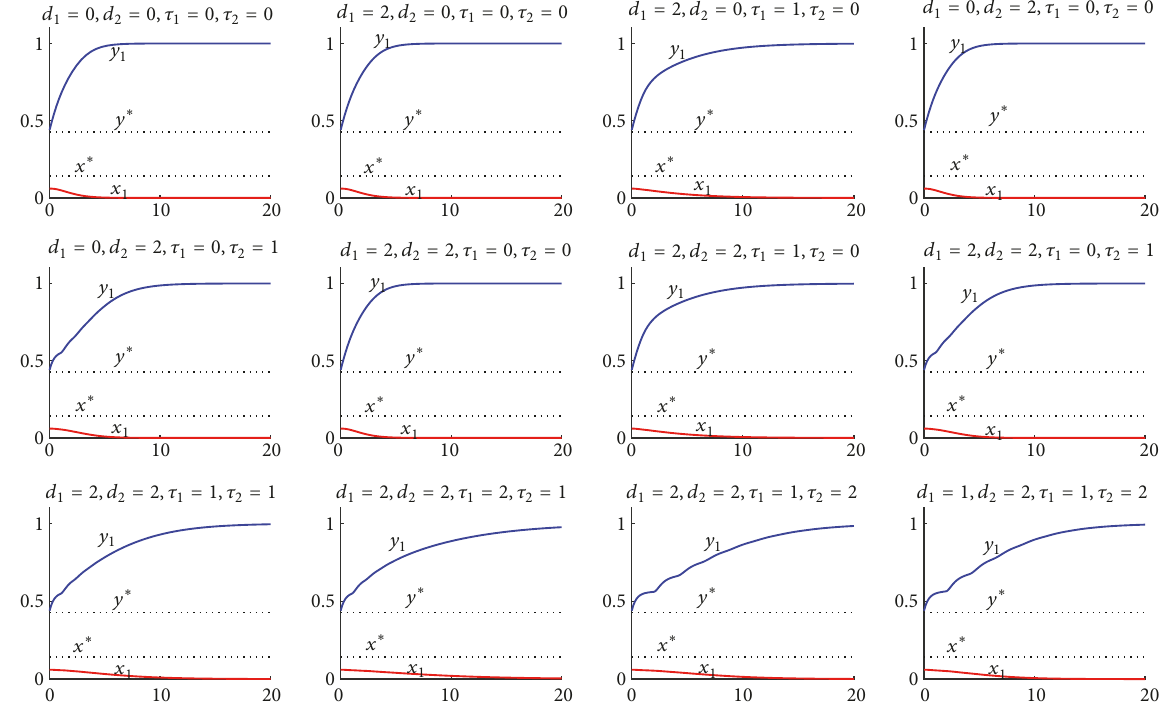
Figure 2: Numerical solutions of system (2). The symmetric coexistence equilibrium is unstable with parameters 𝑎 = 2 , 𝑏 = 4 , and 𝜌 = 2 . Initial condition is set as (𝑥 1 (0),𝑦 1 (0),𝑥 2 (0),𝑦 2 (0)) = (0.06, 0.44, 0.06, 0.44) .